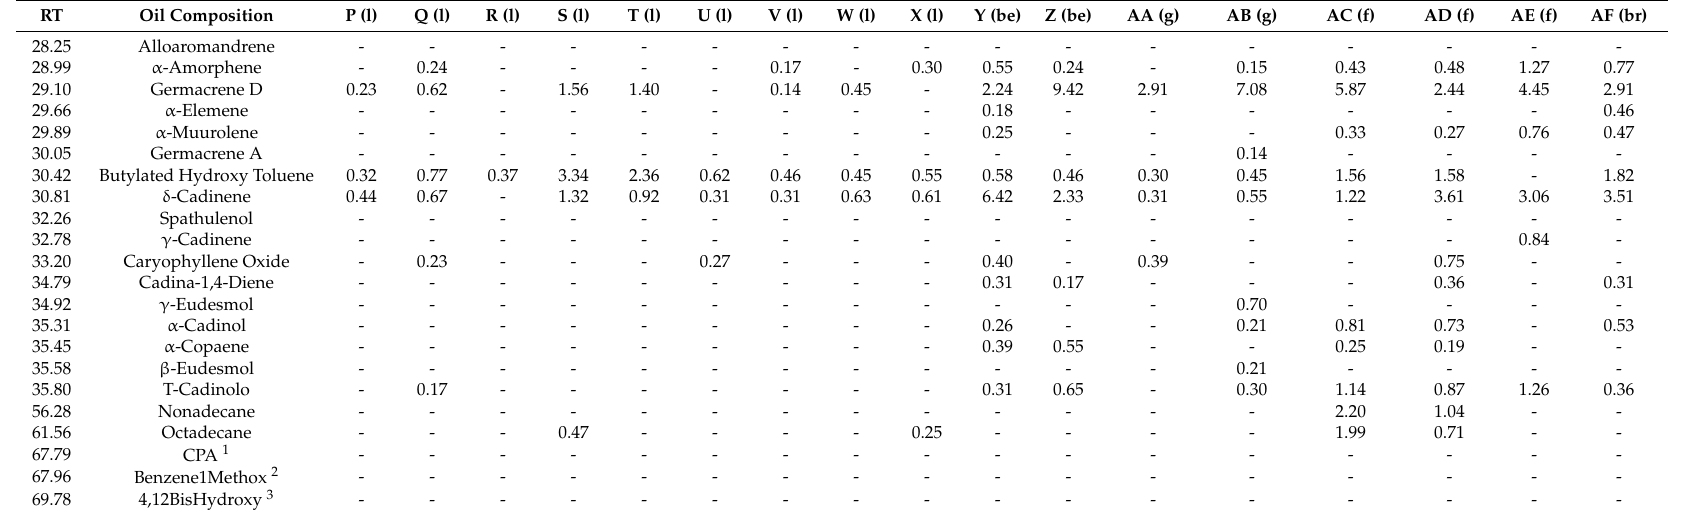
- - - - - - - - - Different Essential Oil samples were identified progressively using letters from P–Z and AA–AF. (l) leaves, (be) berries, (br) branches, (f) flowers, (r) resin, (g) galls. RT: retention time. Values are percent of the total oil